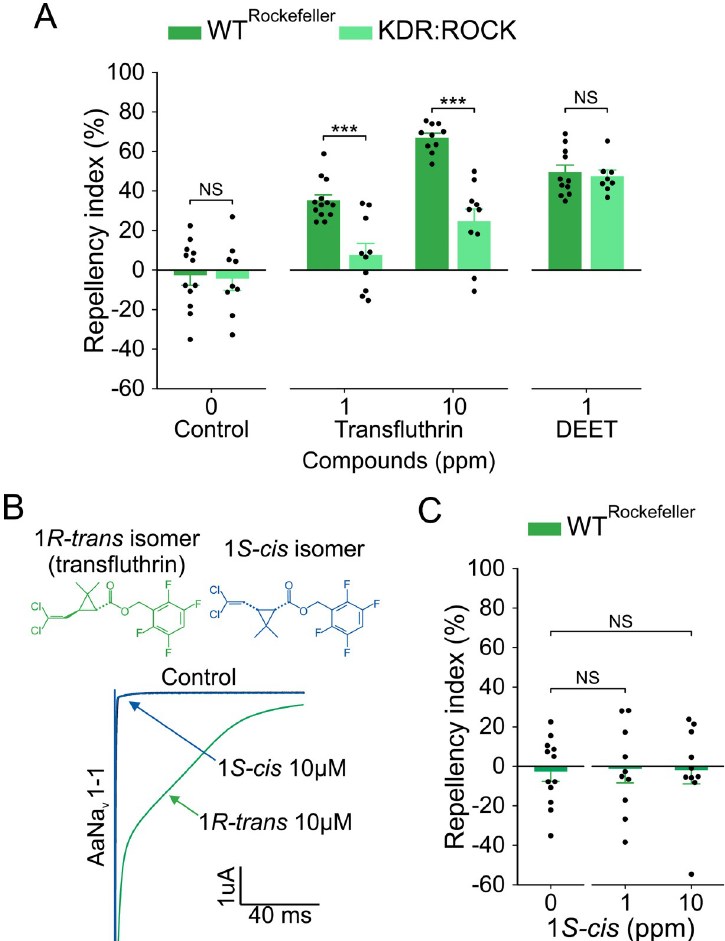
Fig 4. Transfluthrin repellency depends on its action on voltage-gated sodium channels. (A) Repellency by transfluthrin and DEET in Rockefeller and KDR:ROCK mosquitoes. Student’s t -test, for control: t = 0.20, df = 19, P = 0.840, for transfluthrin 1 ppm: t = 4.62, df = 21, P < 0.001, for transfluthrin 10 ppm: t = 6.39, df = 18, P < 0.001, for DEET: t = 0.39, df = 17, P = 0.701, NS = not significant, ��� P < 0.001; n values for: KDR:ROCK for DEET = 8, KDR: ROCK for control = 9, Rockefeller for DEET = 11, Rockefeller for control = 12, Rockefeller for transfluthrin 1 ppm = 13, and the rest = 10. (B) Measurement of tail-current induced by 1R-trans (transfluthrin) or 1S-cis isomers following a 100-pulse train of 5-ms depolarization from -120 mV to 0 mV with 5-ms interval from AaNa v 1-1 channels in Xenopus oocytes [35]. (C) Repellency by 1S-cis isomer in Rockefeller; Student’s t -test, for 0 vs 1 ppm: t = 0.1, df = 20, P = 0.922, for 0 vs 10 ppm: t = 0.16, df = 20, P = 0.871, NS = not significant; n values for: control = 12, and the rest = 10. The controls represent the baseline activity in response to the solvent. Data in panels A and C are presented as mean ± SEM. Dots over the bars represent individual replicate